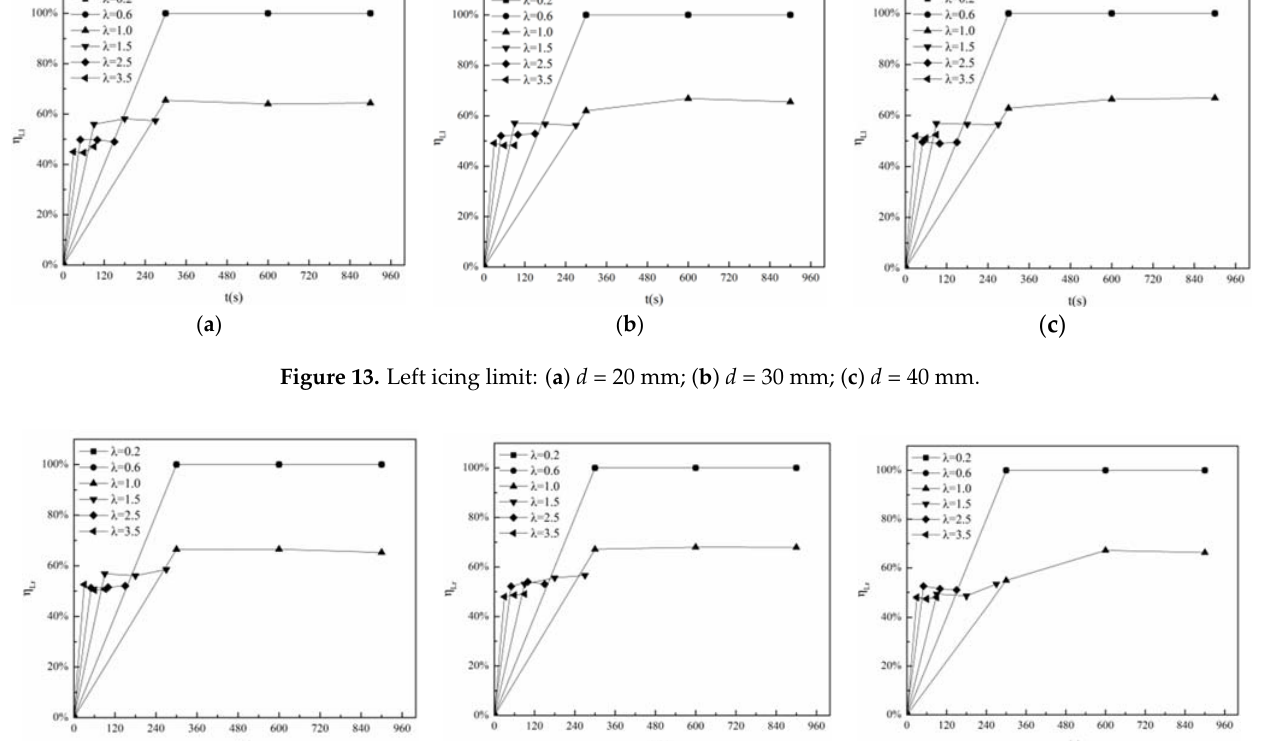
Figure 12. Variations of the dimensionless stagnation point thickness with the icing time: ( a ) d = 20 mm; ( b ) d = 30 mm; ( c ) d = 40 mm.